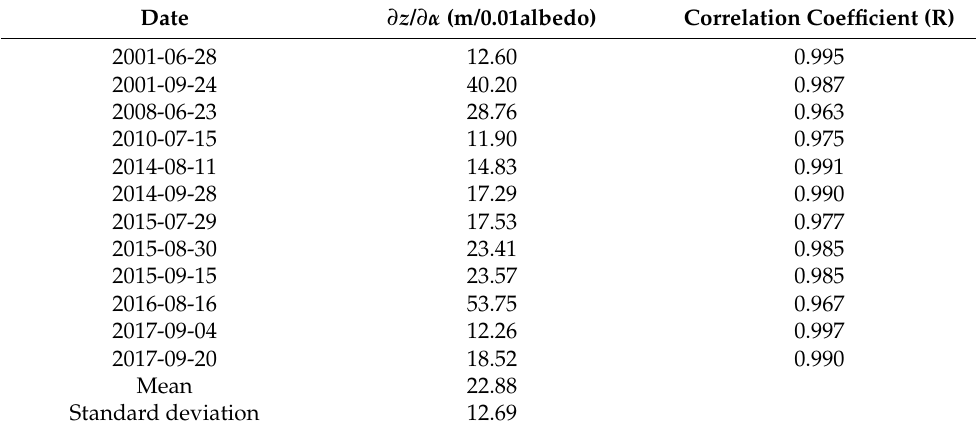
Table 2. The variation in the altitude–albedo gradient ( ∂ z / ∂α ) within elevations of 200 m of the equilibrium line altitude (ELA) for the Chhota Shigri glacier. ∂ z / ∂ α (m/0.01albedo)